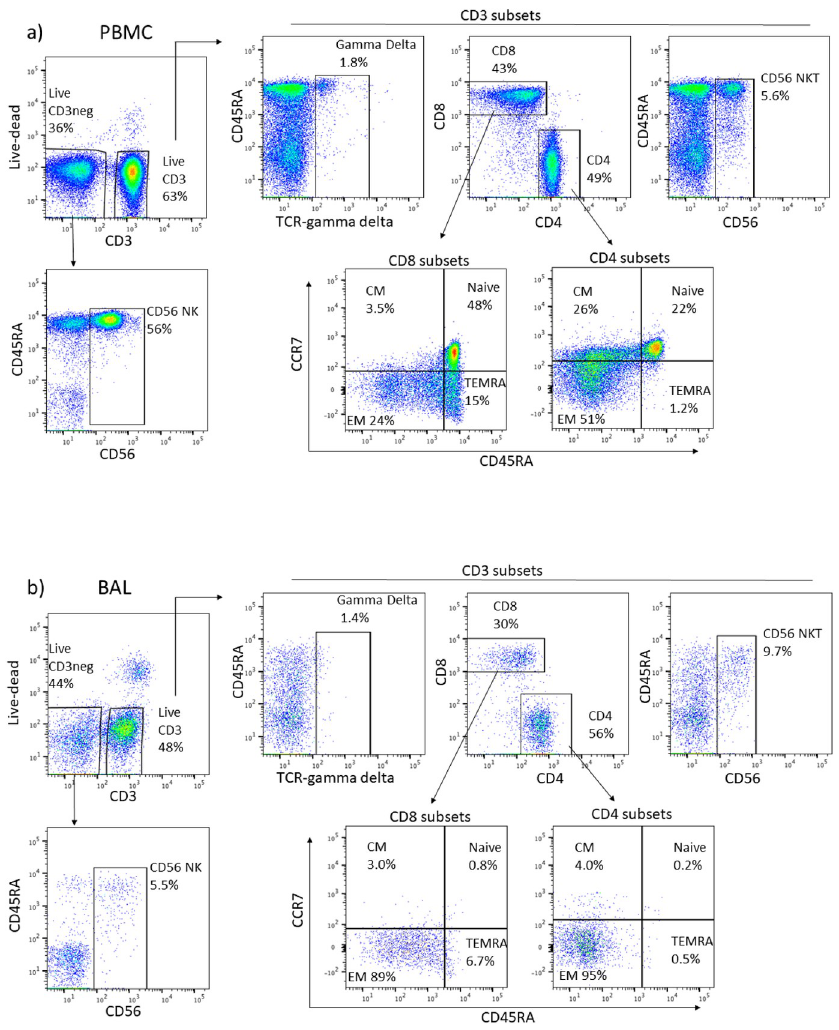
Fig 1. A representative flow analysis for a) PBMC and b) BAL cells. CD56 NK percentage was quantified as a subset of the live CD3- population. Live CD3 lymphocytes were gated as shown to determine gamma delta, CD56 NKT, CD8, and CD4 subsets. CD45RA and CCR7 markers were then used to subset CD4 and CD8 cells into CM, EM, Naive and TEMRA